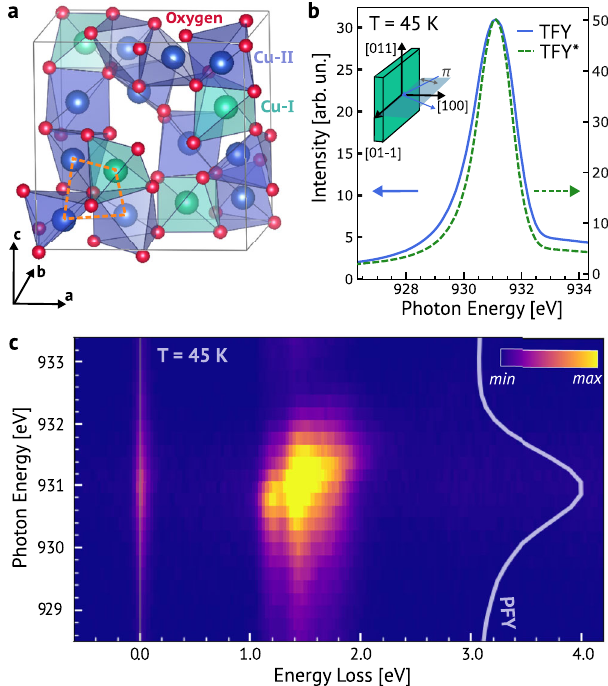
Fig. 1 Overview of the crystal structure, experimental con fi guration, and Cu L 3 X-ray absorption spectroscopy (XAS) and resonant inelastic X-ray scattering (RIXS) data. a Cu 2 OSeO 3 unit cell ( a = 8.925 Å ). The orange dashed line highlights the magnetic tetrahedron unit. b Cu L 3 XAS spectrum in terms of total fl uorescence yield (TFY), at T = 45 K. TFY * is the spectrum after correction for self-absorption and saturation effects. c RIXS energy map with linear color scale for the intensity, also at T = 45 K. The thin solid line displays the partial fl uorescence yield (PFY) signal, obtained integrating the RIXS spectra up to 10 eV. The inset in panel b displays the sample orientation used for these measurements, with [100] and [01-1] axes lying within the scattering plane. Incoming π polarized x-rays were used for all